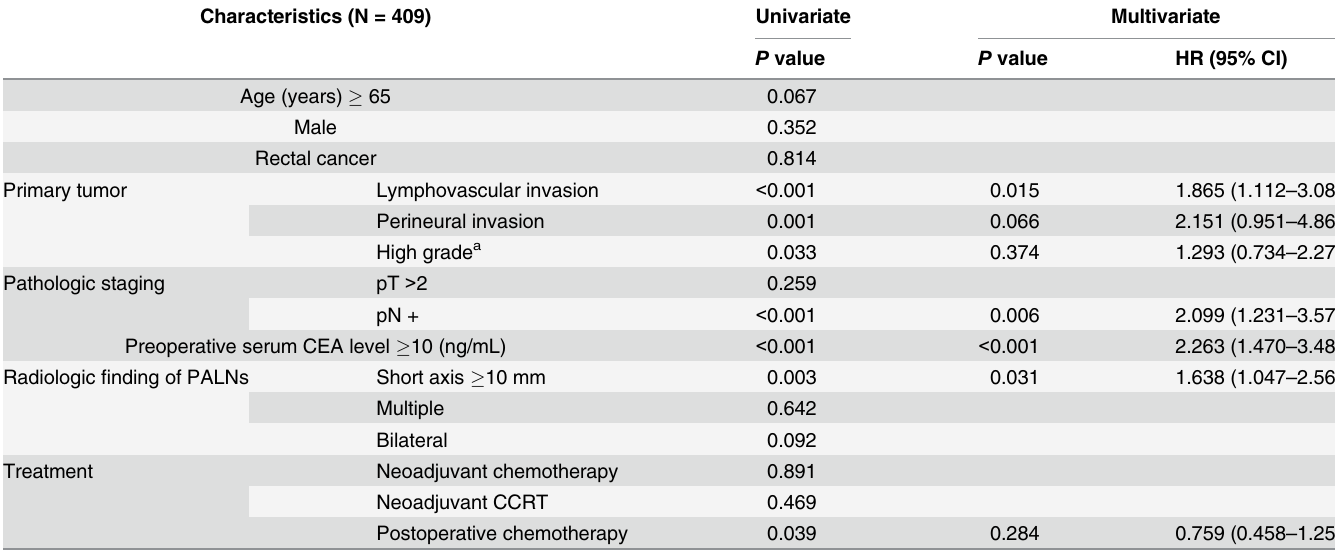
Table 4. Univariate and multivariate Cox regression analysis of prognostic factors for overall survival in patients with visible PALNs. Characteristics (N = 409)